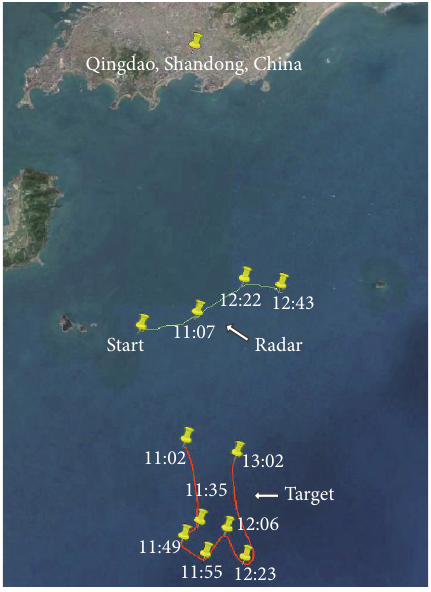
Figure 14: Routes of radar platform and cooperative